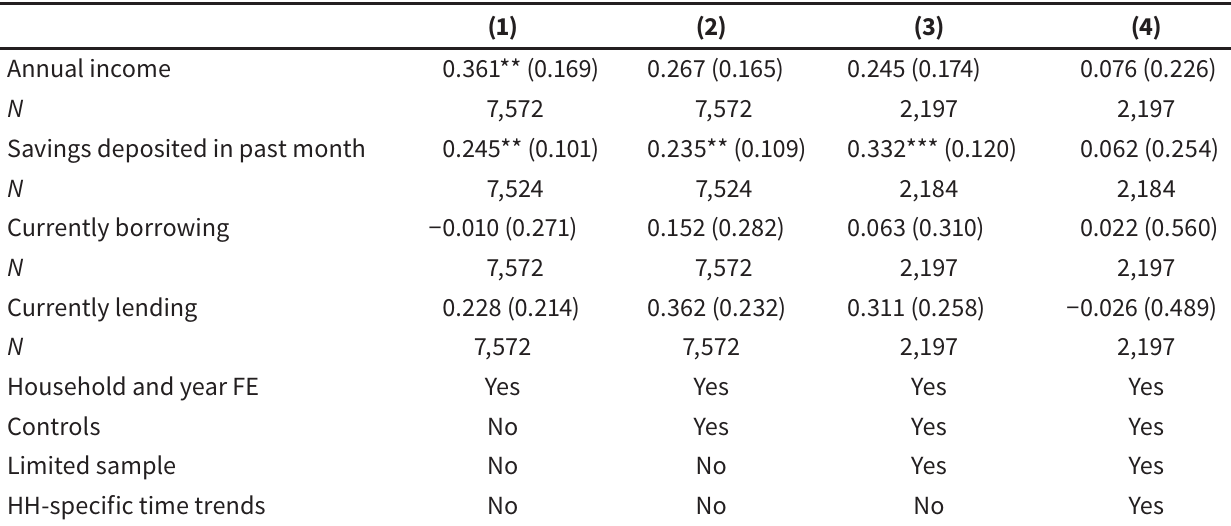
Changes in income and financial behavior ( asinh ) as the husband’s migrant status changes – only considering migration spells outside of Nepal and lasting >6